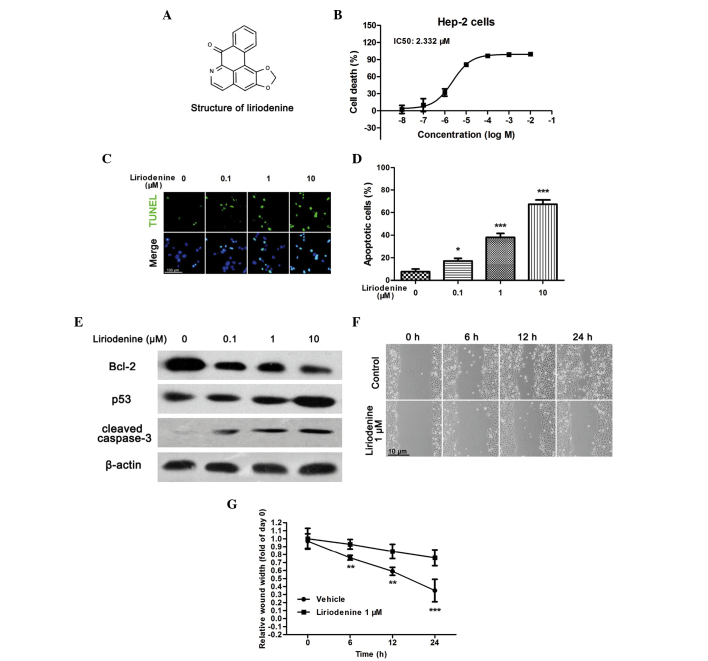
Liriodenine administration induces apoptosis and the inhibition of cellular migration in HEp-2 cells. (A) The structure of liriodenine, 8H-benzo[g]-1,3-benzodioxolo[6,5,4-de]-quinolin-8-one. (B) IC50 non-linear fit curve showing the effect of varying concentrations of liriodenine on the cellular viability of HEp-2 cells, which was determined by MTT assay. (C) Terminal deoxynucleotidyl transferase dUTP nick end labeling (TUNEL) revealing apoptotic cells. TUNEL-positive cells were identified by green fluorescence. All nuclei were stained blue with Hoechst 33342. Scale bar referring to all panels, 100 μm. (D) The cellular apoptotic rate according to the different concentrations of liriodenine was calculated. *P<0.05 and ***P<0.001 compared with the vehicle-treated group (n=10). (E) Western blot analysis revealing the expression of B-cell lymphoma 2 protein (Bcl-2), p53 and cleaved caspase-3 following treatment with different concentrations of liriodenine. β-actin was used as the internal control. All blots were repeated at least three times. (F) Effect of 1 μM liriodenine upon cellular migration was investigated. Representative images revealing the extent of migration at specific time-points following treatment. Scale bar referring to all panels, 10 μm. (G) Wound width was measured and the relative values are presented. **P<0.01 and ***P<0.001 compared with the vehicle-treated group (n=3). IC50, half maximal inhibitory concentration.